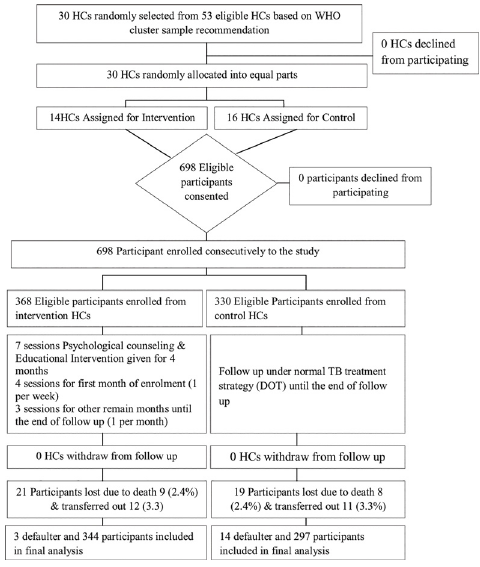
Fig 1. Cluster Randomized Control Trial Flow